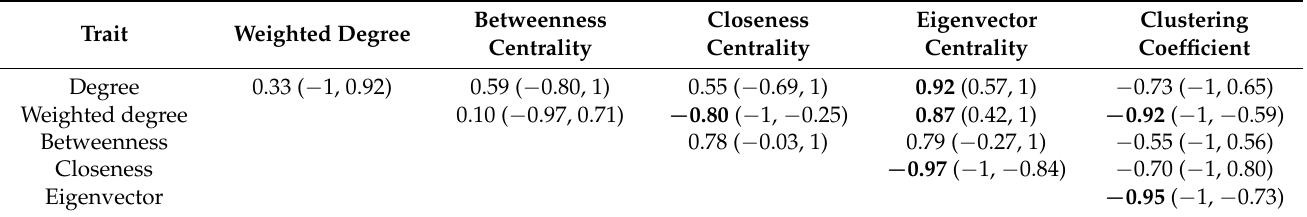
Table 4. Posterior means of the genetic correlations and the 95% highest posterior density intervals (HPD95%) for social network analysis traits for aggressive behaviour 1